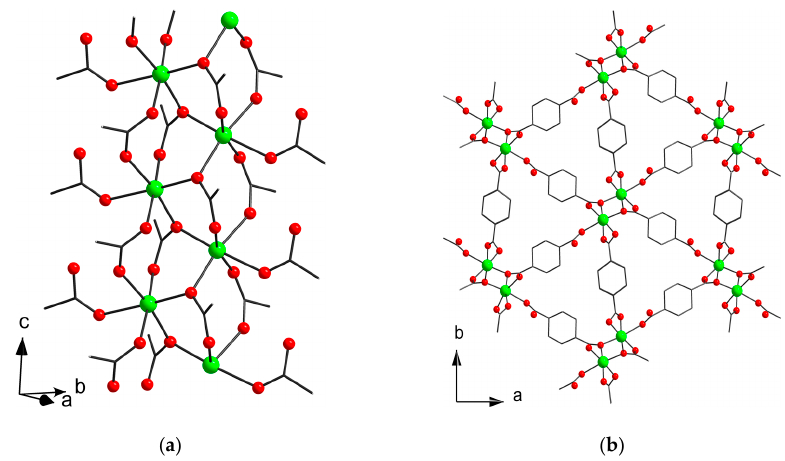
Figure 4. Fragment of polymeric chain in ( a ) and metal–organic framework ( b ) in 5o (CCDC 1973666). Hydrogen atoms are omitted. Only one of possible orientations of chdc 2 − ligand is shown.